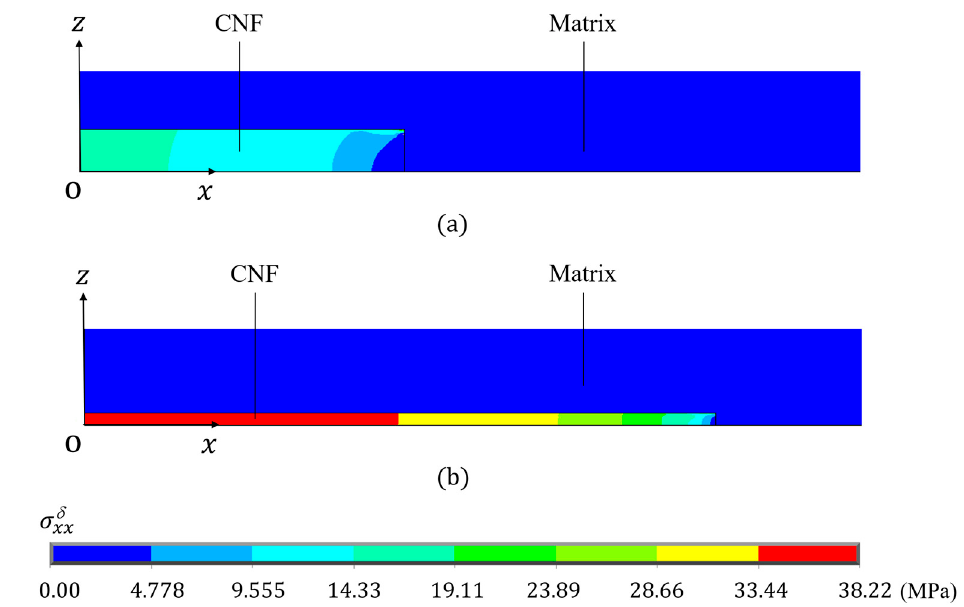
Figure 9. Predicted tensile stress distribution of CNF in RVE with 0.073 vol % under the applied tensile stress of 1 MPa. The aspect ratios are ( a ) 7.5 and ( b ) 50, respectively.